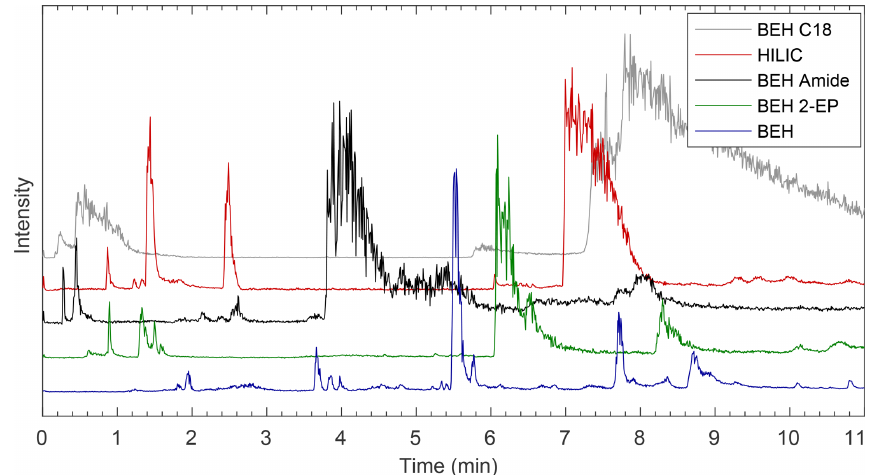
Figure 2. Comparison of EICs from five columns using a methanol modifier. The first 11min is shown to make clear the differences in separation between lower-intensity peaks. Full chromatograms are shown in Fig. S3 and the masses monitored are shown in Table S3. The more polar BEH columns (BEH, BEH Amide, BEH 2-EP) provide better separation, and the BEH provides the best separation of those columns